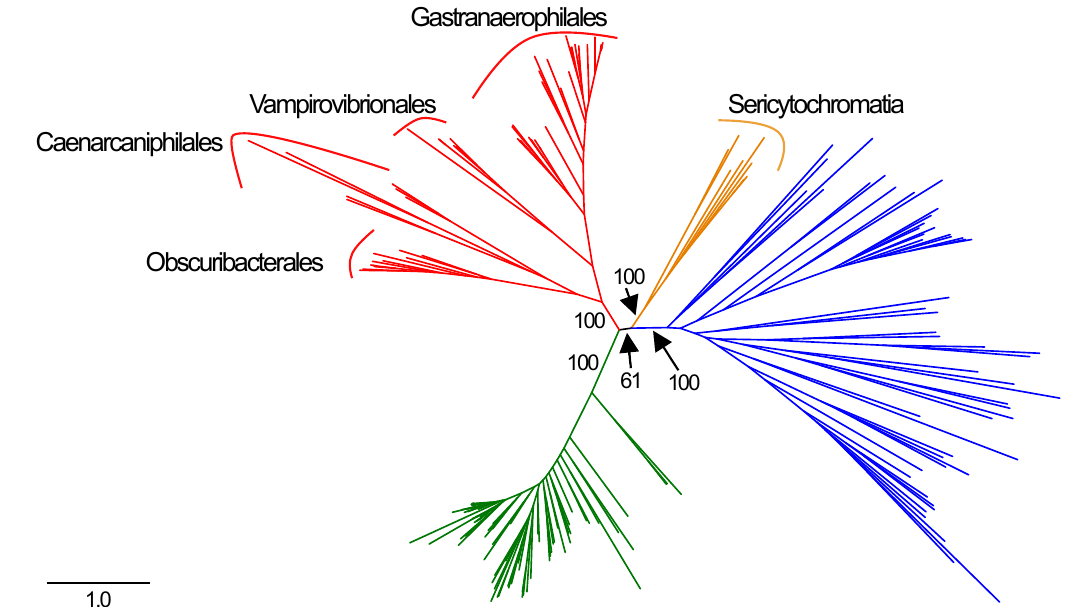
Figure 1. Concatenated, single-copy marker gene tree constructed using the Bacteria_71 collection of single-copy core genes from Anvi’o [20]. Cyanobacteria are indicated in green, Melainabacteria in red, Sericytochromatia in orange, and other phyla in blue. Order-level divisions are indicated for the Melainabacteria. Bootstrap values are indicated for key splits.